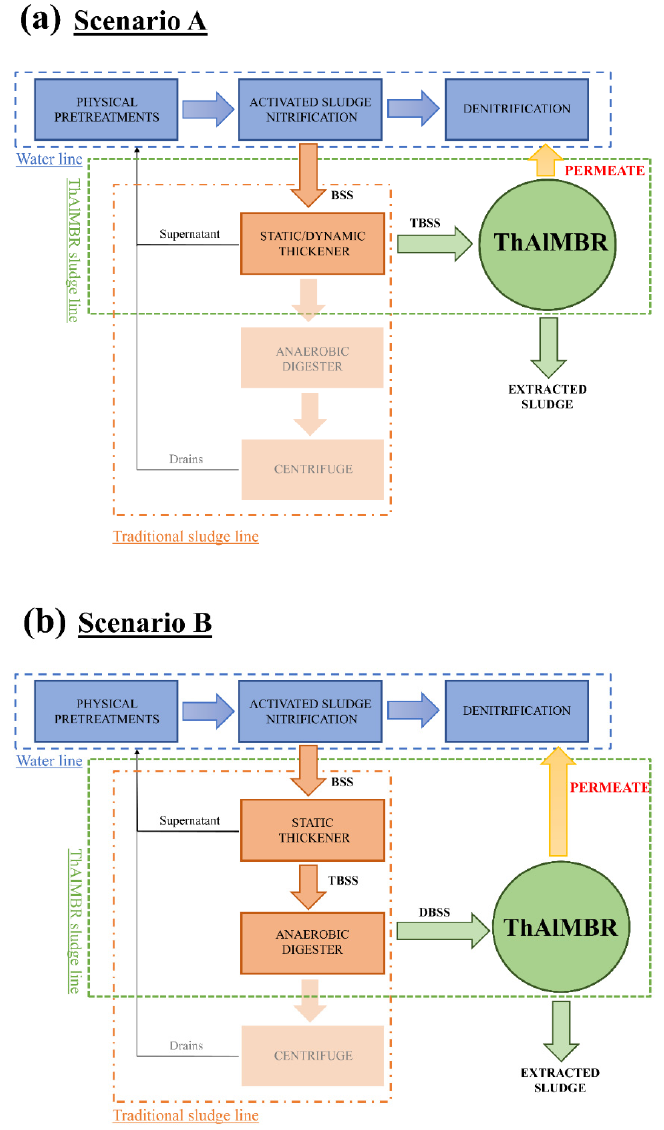
Figure 1. Applications of ThAlMBR in sludge line. ( a ) Scenario A: downstream of the thickener, ( b ) Scenario B: downstream of the anaerobic digester. BSS: biological sewage sludge, TBSS: thickened biological sewage sludge, DBSS: digested biological sewage sludge, VS: volatile solids.